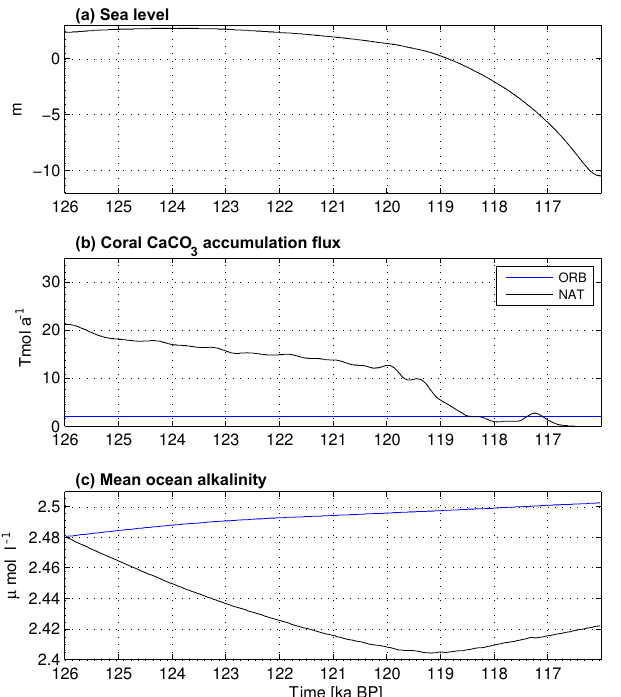
Figure 9. Sea level forcing (a) , shallow-water CaCO 3 accumula- tion flux (b) and mean ocean alkalinity (c) in the Eemian experi- ments. Plots have been smoothed for clarity.